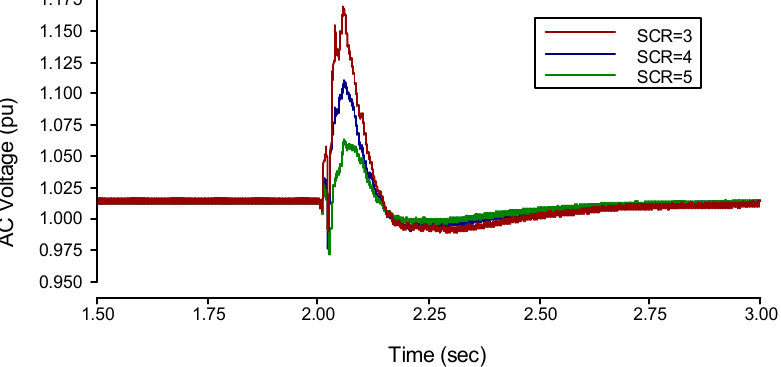
Figure 4. Transient State analysis of the LCC-HVDC system results on the Inverter